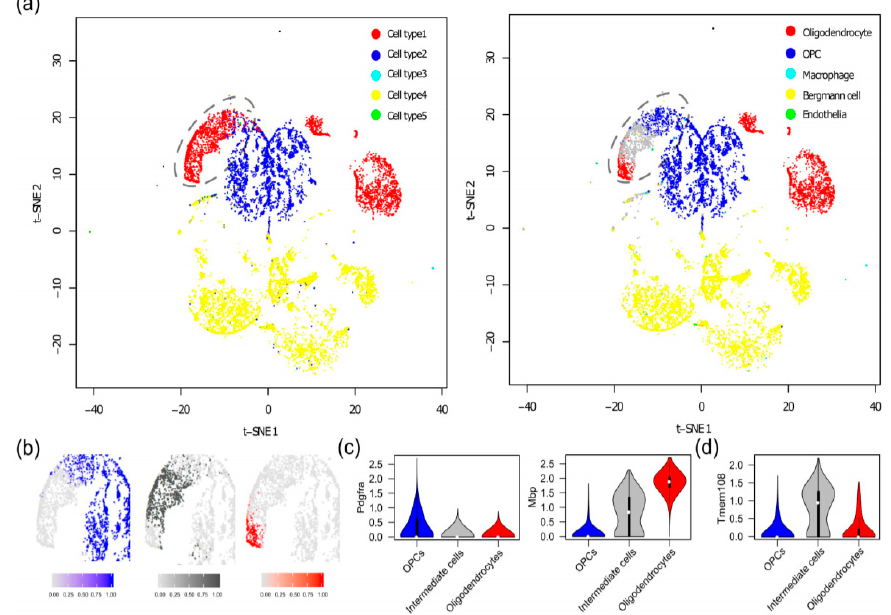
Figure 4. Discovery of a new stage of oligodendrocyte development in mouse brain. ( a ) t-SNE plot showing the clusters of cells detected by the manual inspection method employed in the original publication (left) and the cell types assigned by SCINA (right). ( b ) Density plots of cell type assignment probabilities generated by SCINA. ( c ) Violin plots showing the expression of Mbp and Pdgfra and ( d ) violin plot showing the expression of Tmem108 in oligodendrocyte precursor cells (OPCs), oligodendrocytes, and the intermediate stage of cells.